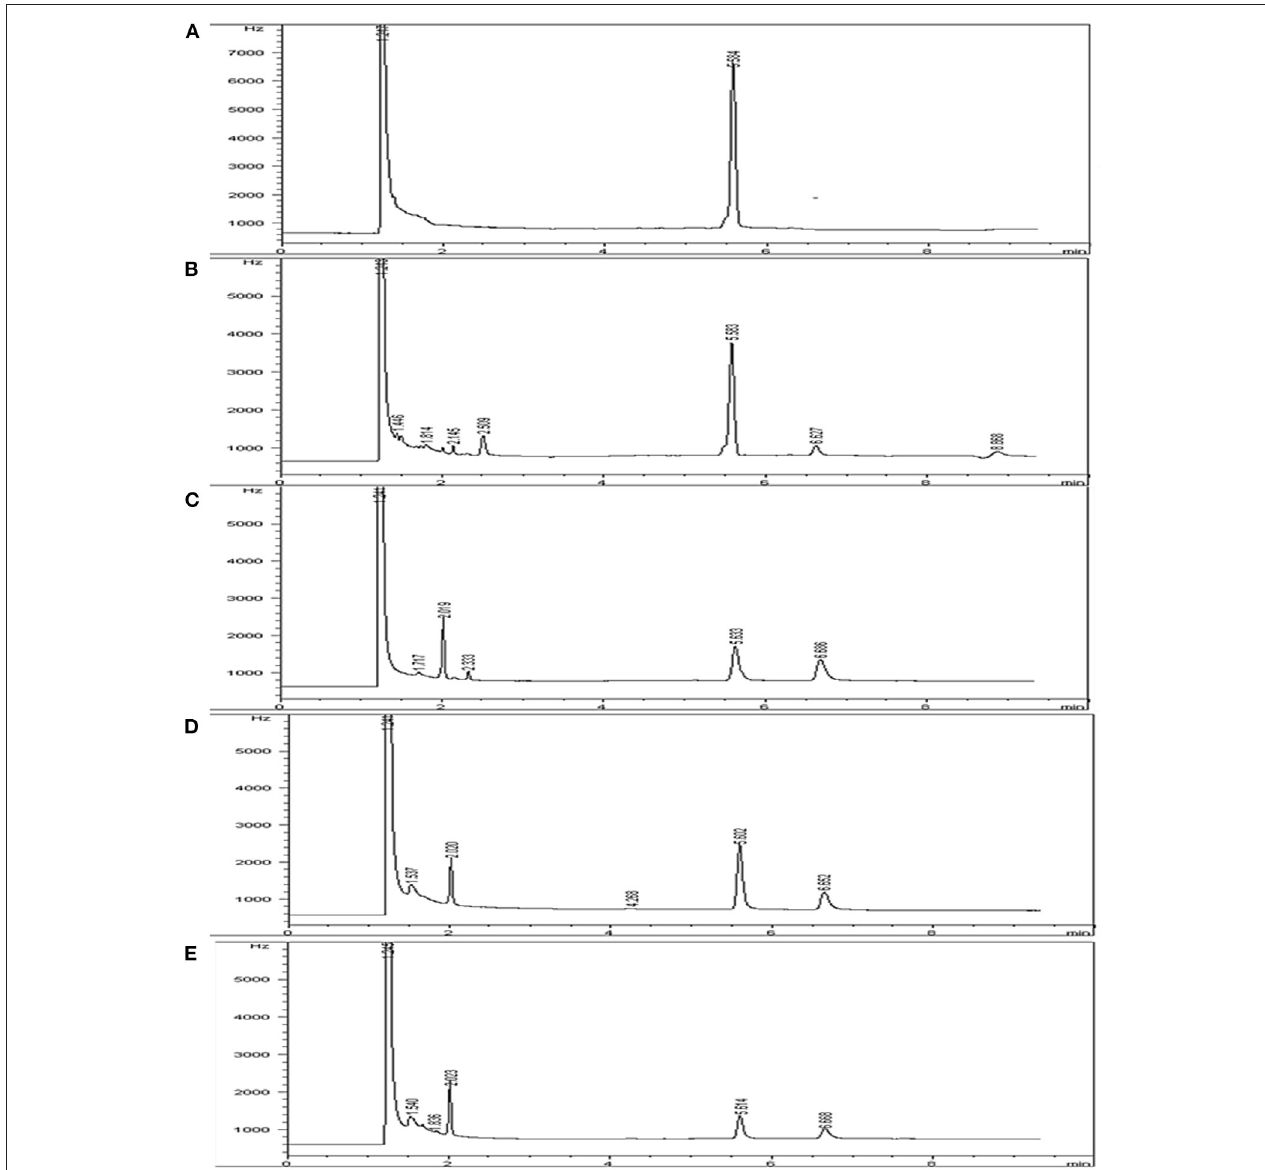
FIGURE 2 | Chromatogram of (A) indoxacarb standard solution, (B) cabbage sample, (C) cabbage field soil sample, (D) tomato sample, and (E) tomato field soil sample.